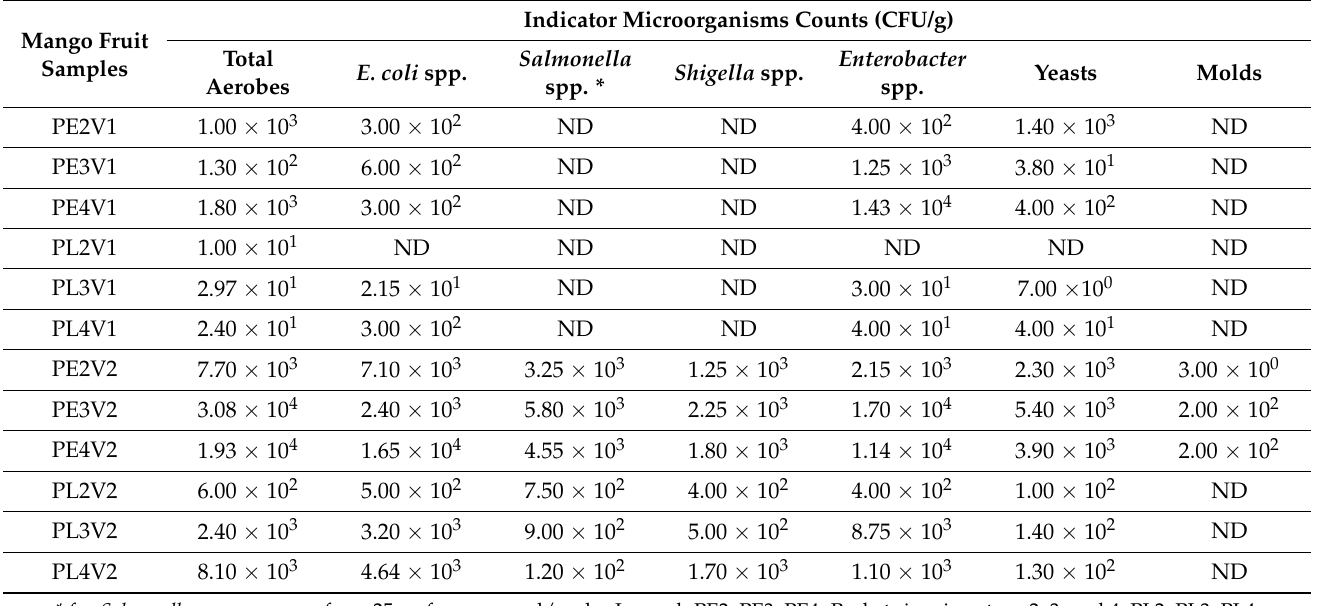
Table 1. Indicator microorganisms counts detected in mango fruits at different stages of ripening expressed as CFU/g. Mango Fruit